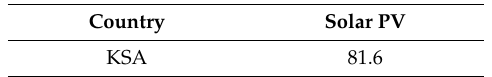
Table 5. Lower limits of installed capacities [MW] considered in this study for Saudi